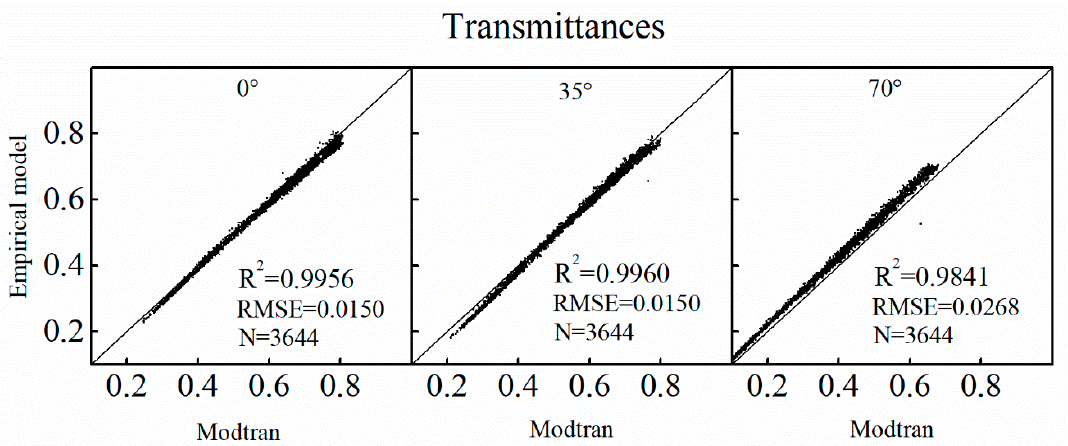
Figure 8. Comparison between Modtran and the empirical model-derived transmittance for FLIR T420 thermal imager.